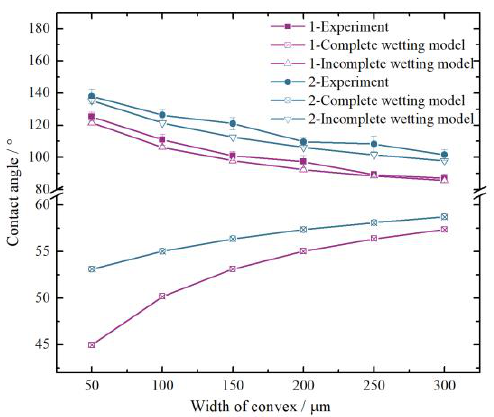
Figure 9. The predicted and experimental contact angle curves.